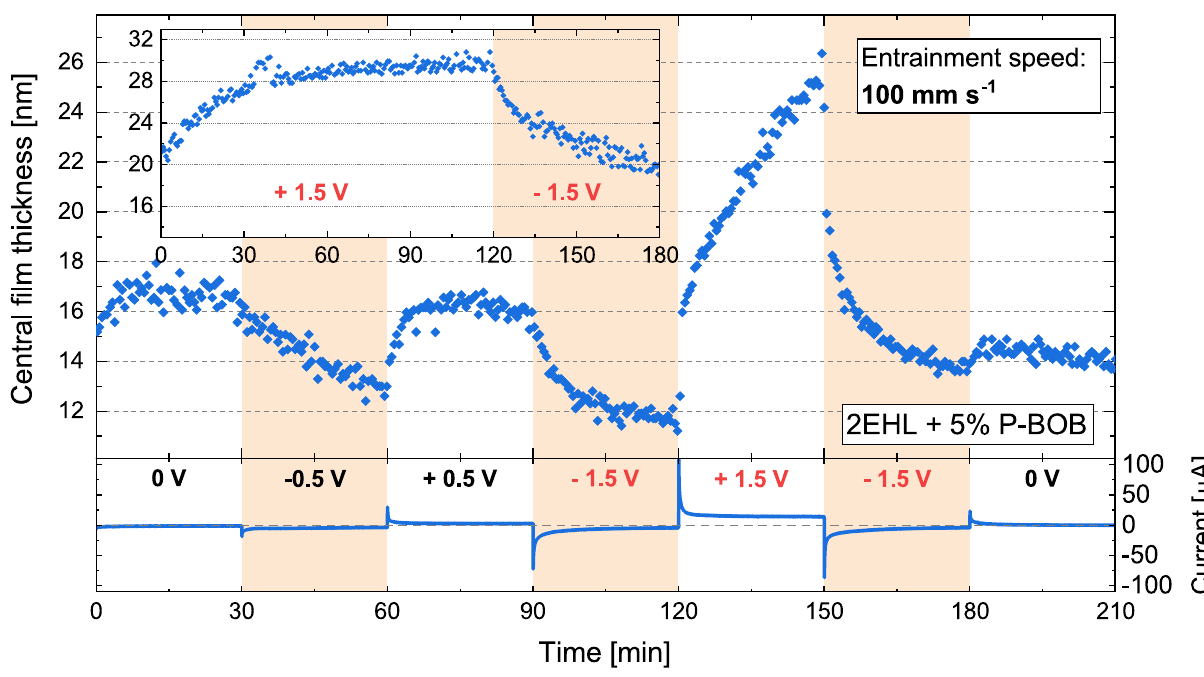
Figure 6. Electroresponse on central film thickness for 2EHL + 5% P-BOB solution with high voltages (− 1.5 and + 1.5 V: outside the electrochemical window) applied. The potential was changed every 30 min, with the first 2 potential changes being within the electrochemical window. The bottom part of the plot shows the current trace corresponding to the applied potential. The figure inset shows a snippet from the continuation of the same test where the high potentials were applied for a longer duration of time (+ 1.5 V for 2 h followed by − 1.5 V for 1